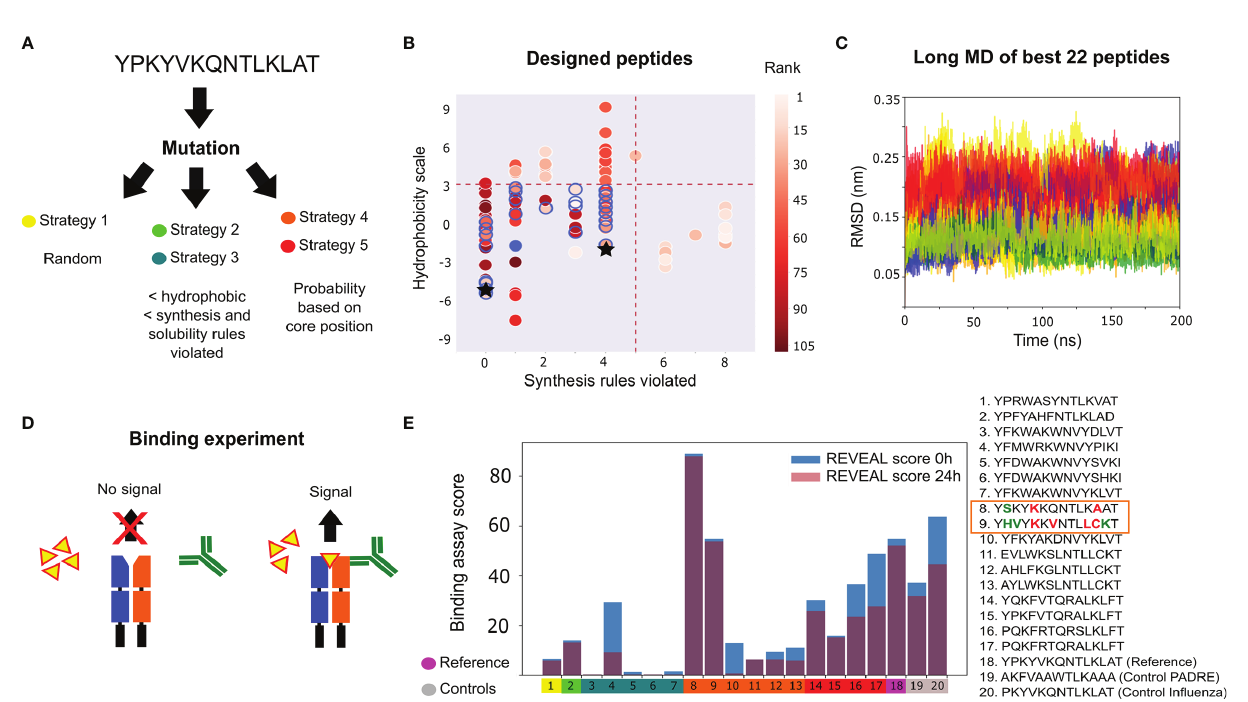
FIGURE 2 | In fl uenza peptide design for binding to a single allele. (A) Design strategies implemented: random mutations (strategy 1), mutations fi ltered by bioinformatic properties (strategies 2 and 3) and mutations fi ltered by MHC II binding motifs (strategies 4 and 5). (B) Hydrophobicity values, the number of synthesis rules violated and the average rank (scoring from 5 ns MD simulations) for the designed peptides. The thresholds (red dashed lines) used for selecting 22 peptides (blue circles) for long MD simulations. The original peptide is represented by a blue- fi lled circle. The controls are represented as black stars. (C) C a RMSD to the starting structure of the 22 selected peptides during the long MD, colored by the mutation strategy panel (A) . (D) Illustration of the Proimmune REVEAL binding assay. The peptide (yellow) binds the MHC II protein. When the components bind in the correct conformation, a positive signal is generated via a labelled antibody (green). (E) Experimental results of the REVEAL assay for the 17 designed peptides, the original sequence and two positive controls (PADRE and In fl uenza peptide PKYVKQNTLKLAT). The REVEAL binding score is a value between 0 and 100, which is determined by the comparison with a control T-cell epitope. The peptides are split into the fi ve mutation strategies [color code as in panel (A) ]. The scores are shown at 0 hours (blue bar) and after 24 hours (purple bar). The box highlights the two peptides with better binding than the reference sequence, with the modi fi cations in bold, and colored in red and green to represent changes in the core and fl anking regions,